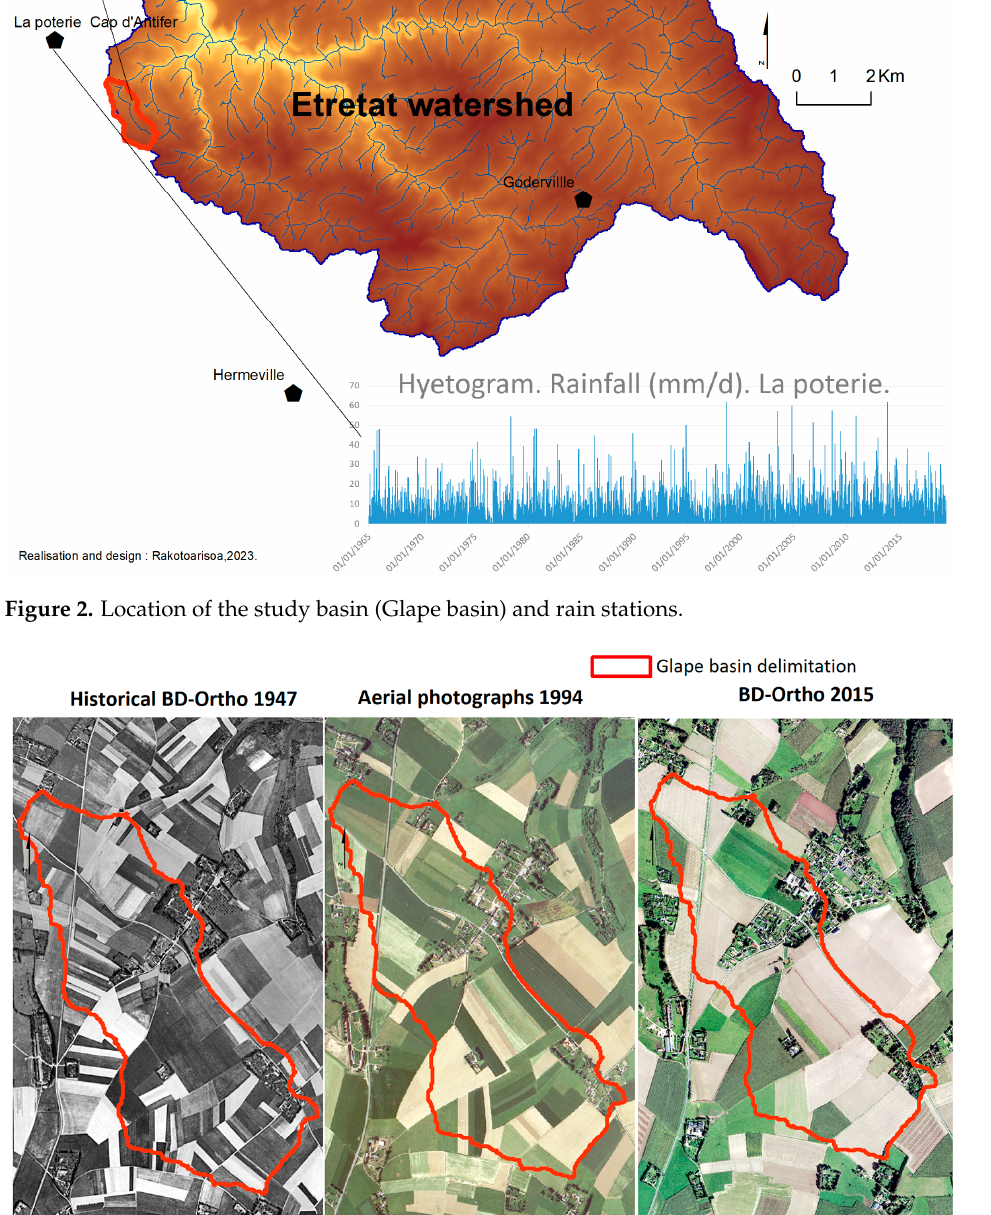
Figure 2. Location of the study basin (Glape basin) and rain stations.